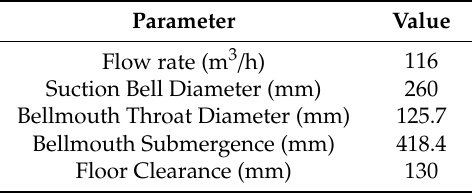
Table 2. Flow parameters for the physical model.